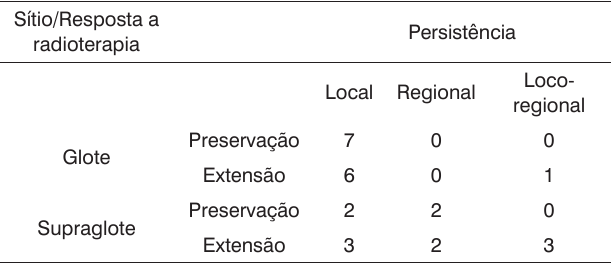
Tabela 3. Distribuição do tipo de persistência ao final da radiotera- pia, de acordo com o sítio do tumor e a indicação de radioterapia. Sítio/Resposta a